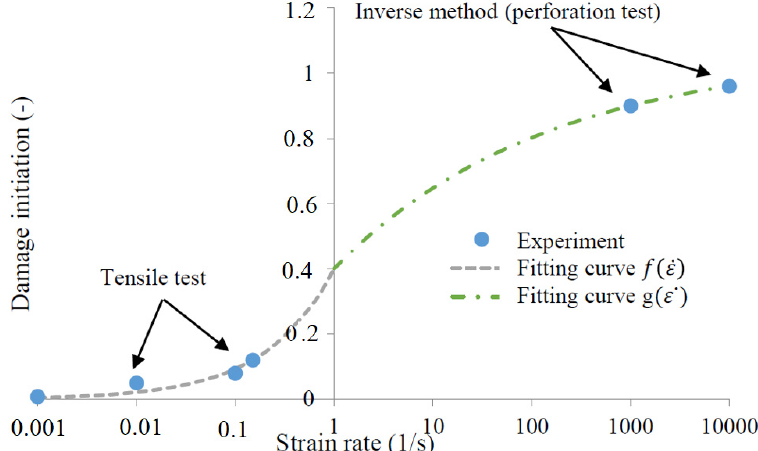
Figure 1. Plot of the failure strain versus plastic strain rate using the optimized model [21].